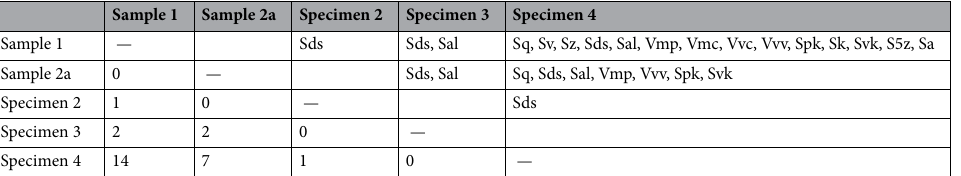
Table 3. Pairwise differences (Tukey HSD) between samples from multiple different individuals with different diets (wild specimens 2–4 and captive (specimen 1), and samples from multiple sites within a tooth (samples